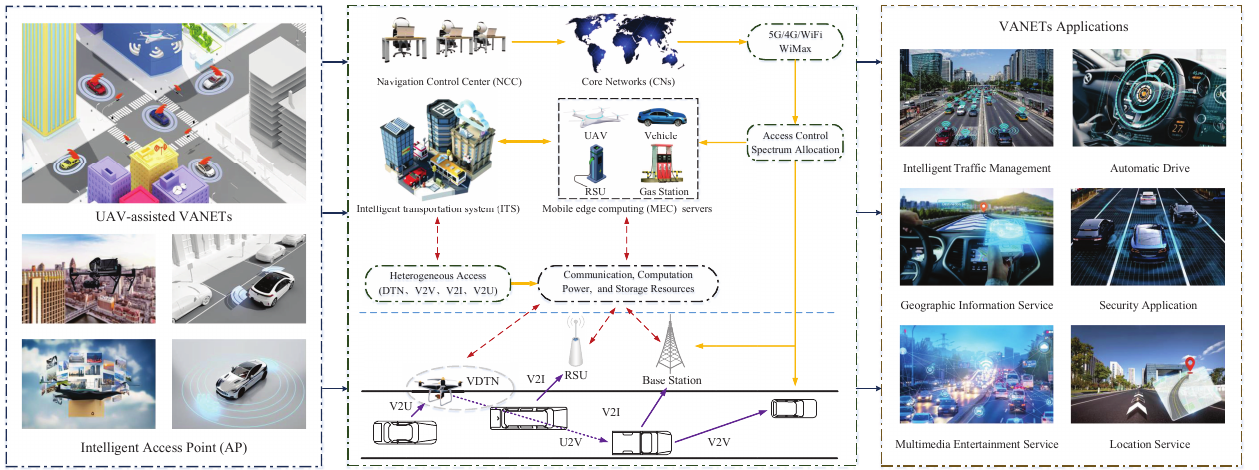
Figure 1. A mobile edge computing (MEC) architecture in unmanned aerial vehicle (UAV)-assisted vehicular ad hoc networks